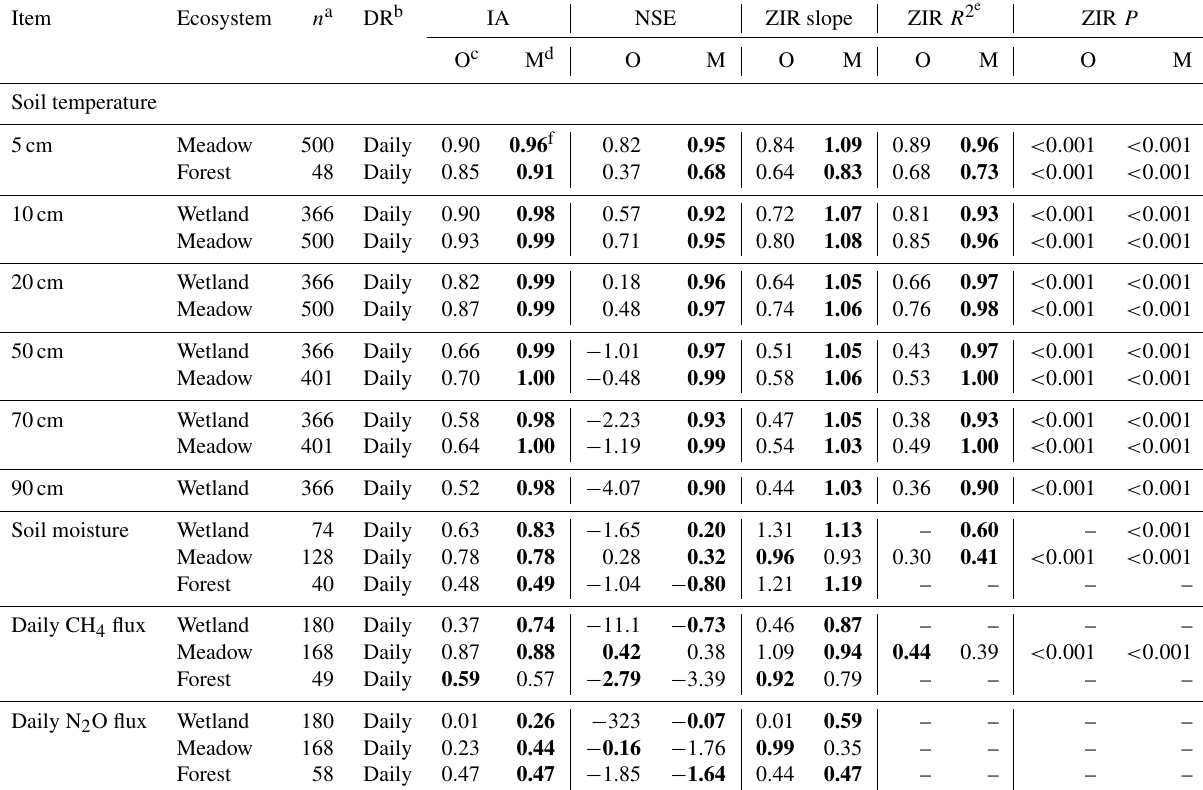
Table 1. Statistics of the validated variables by the original and modified CNMM-DNDC for three typical alpine ecosystems. Item Ecosystem n a DR b IA